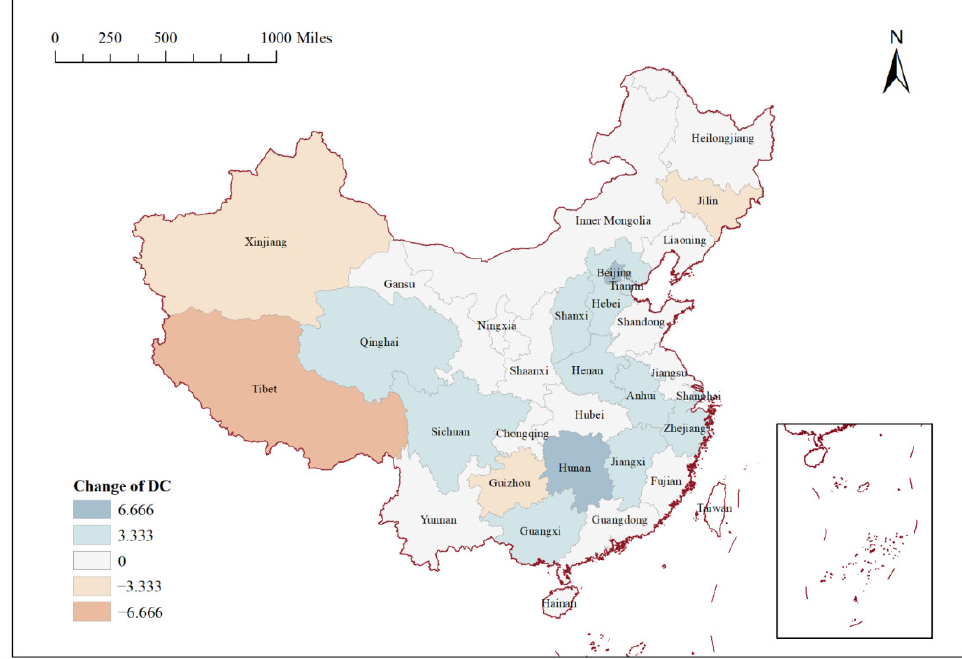
Figure 4. Comparison of point degree centrality by province in 2012 and 2020.